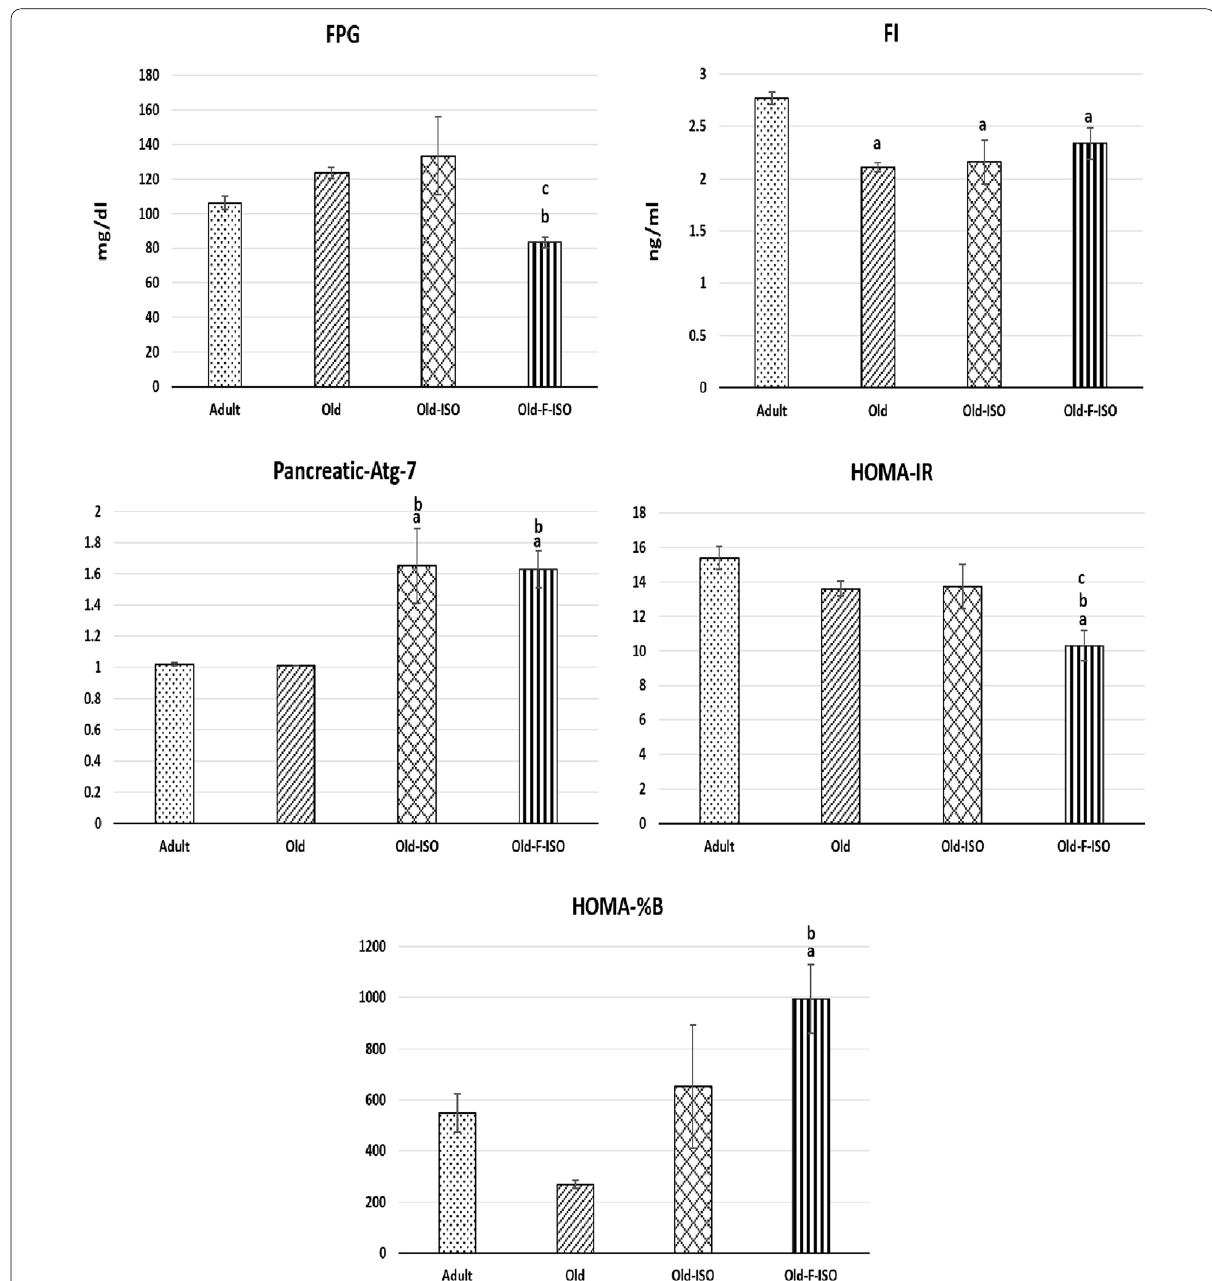
Fig. 2 Changes in fasting plasma glucose (FPG), plasma level of fasting insulin (FI), mRNA expression of pancreatic autophagy marker (Atg‑7), Homeostatic model assessment of insulin resistance (HOMA‑IR), and Homeostatic model assessment of beta cell function (HOMA‑%B), in the four study groups. Data are expressed as mean SEM. Number in parenthesis is the number of rats in each group. a Significance of difference from adult ± group by LSD test at P < 0.05. b Significance of difference from old group by LSD test at P < 0.05. c Significance of difference from Old‑ISO group by LSD test at P <